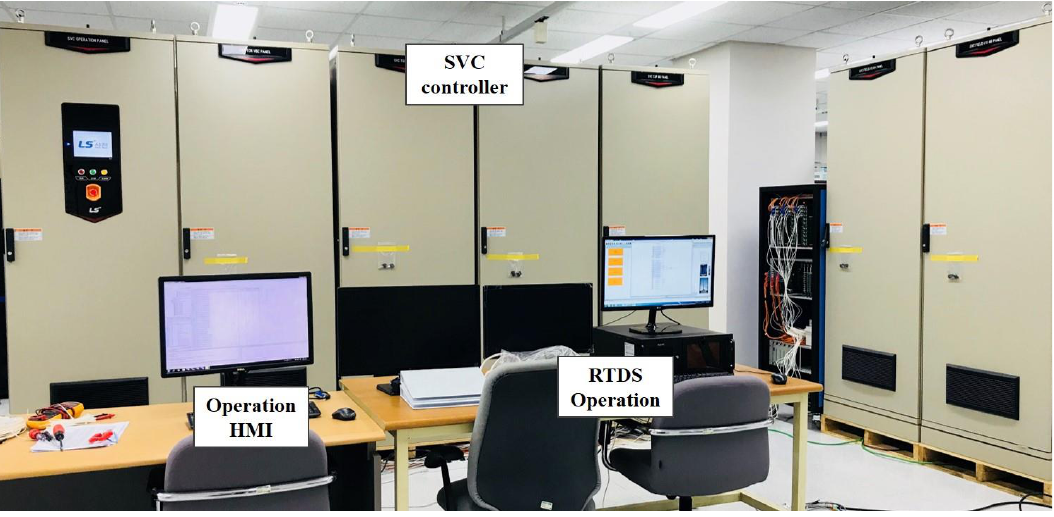
Figure 8. SVC controller interfaced with RTHS.